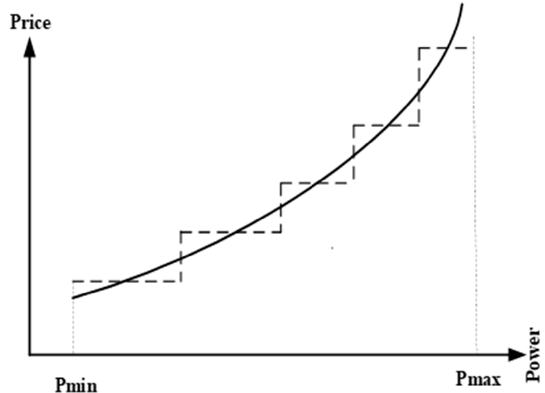
Figure 3. Quadratic Approach.